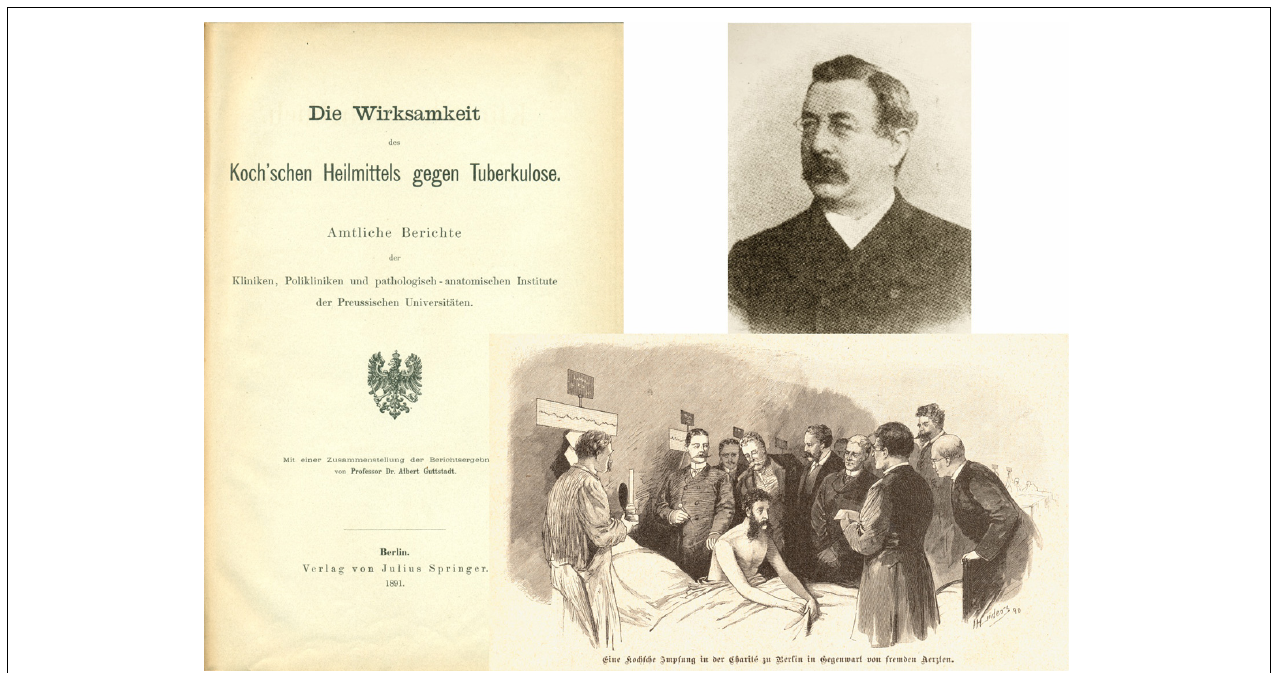
FIGURE 3 | Report describing the clinical trials with Koch’s remedy against TB. The figure shows title page of report and photo of the principle investigator (Guttstadt, 1891; Kaufmann and Winau, 2005). Also shown is a picture from a magazine depicting vaccination of a TB patient with tuberculin in front of medical doctors.